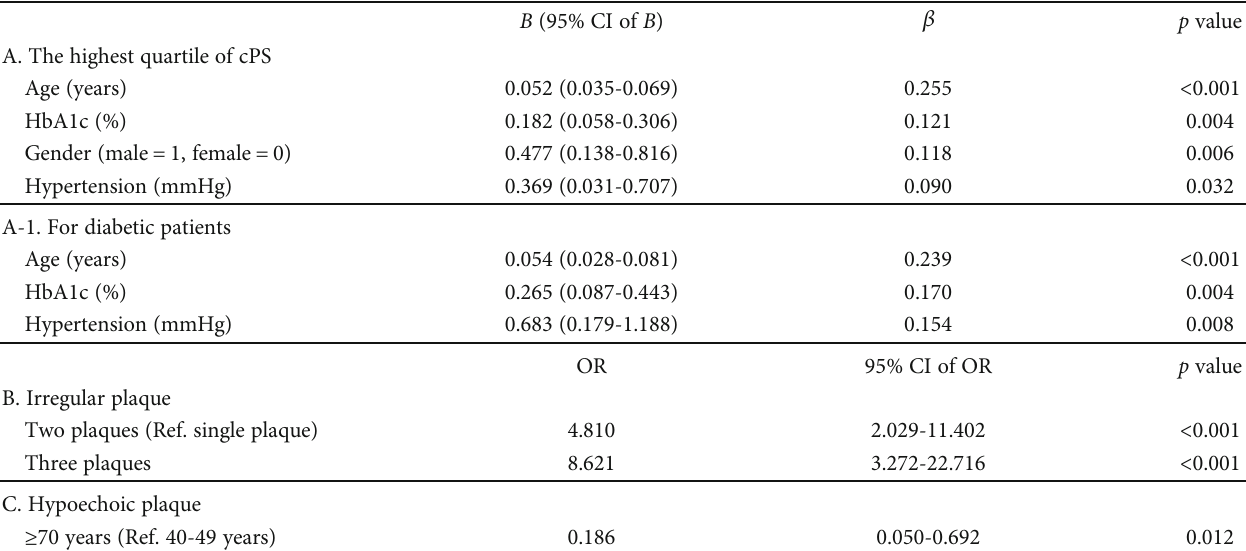
Table 3: Predictors of high-risk plaque.